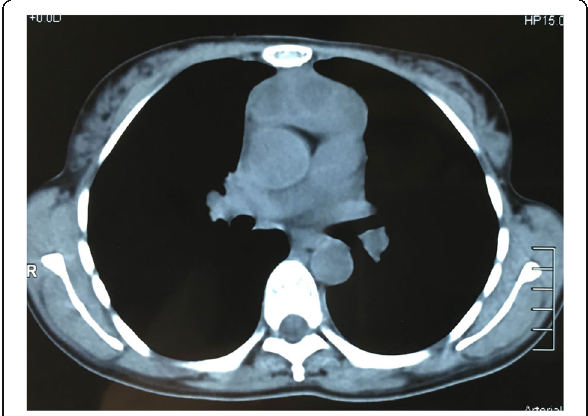
Fig. 1 Computed tomographic findings: chest computed tomogram showed an anterior mediastinal mass composed of multilocular cyst Fig. 2 Gross picture of a type B2 thymoma associated with